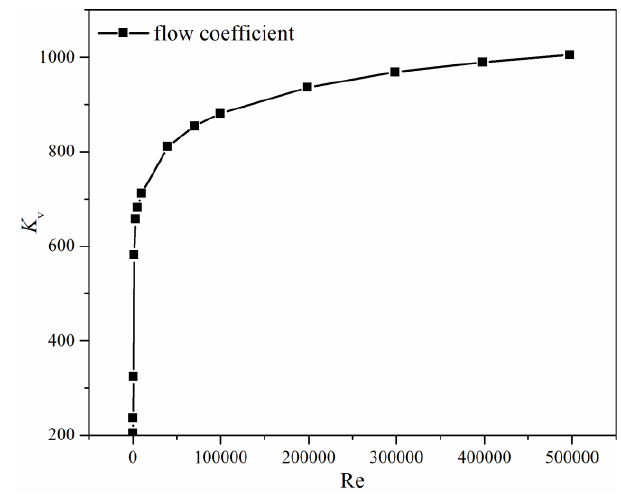
Figure 7. The flow coefficient with different Reynolds number.